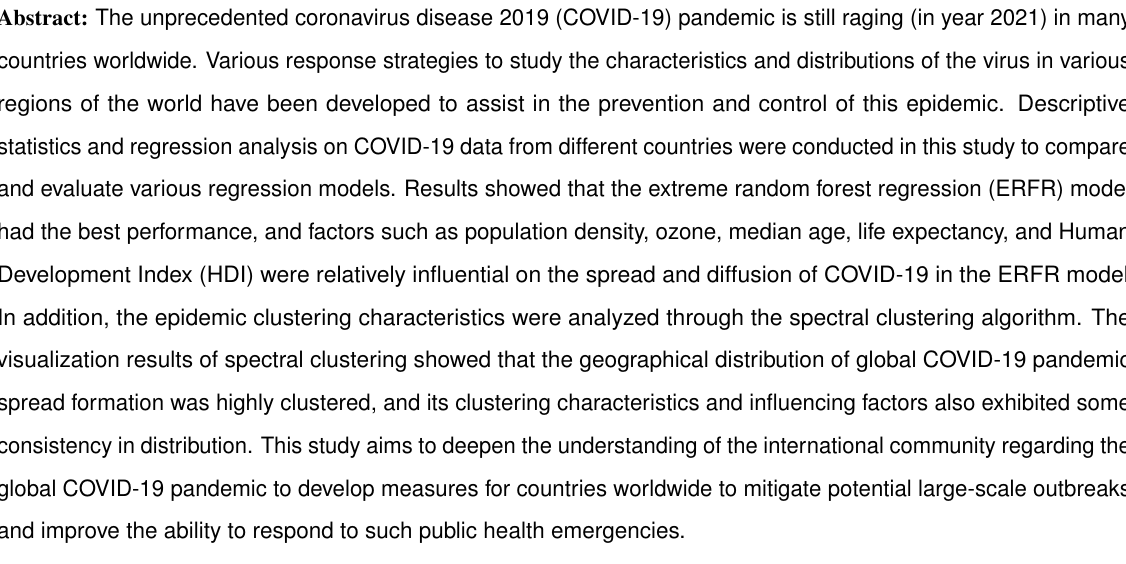
Fig. 1. The main areas of global coronavirus vaccination are amassed in the Americas, Europe, and East Asia, as shown in Fig.